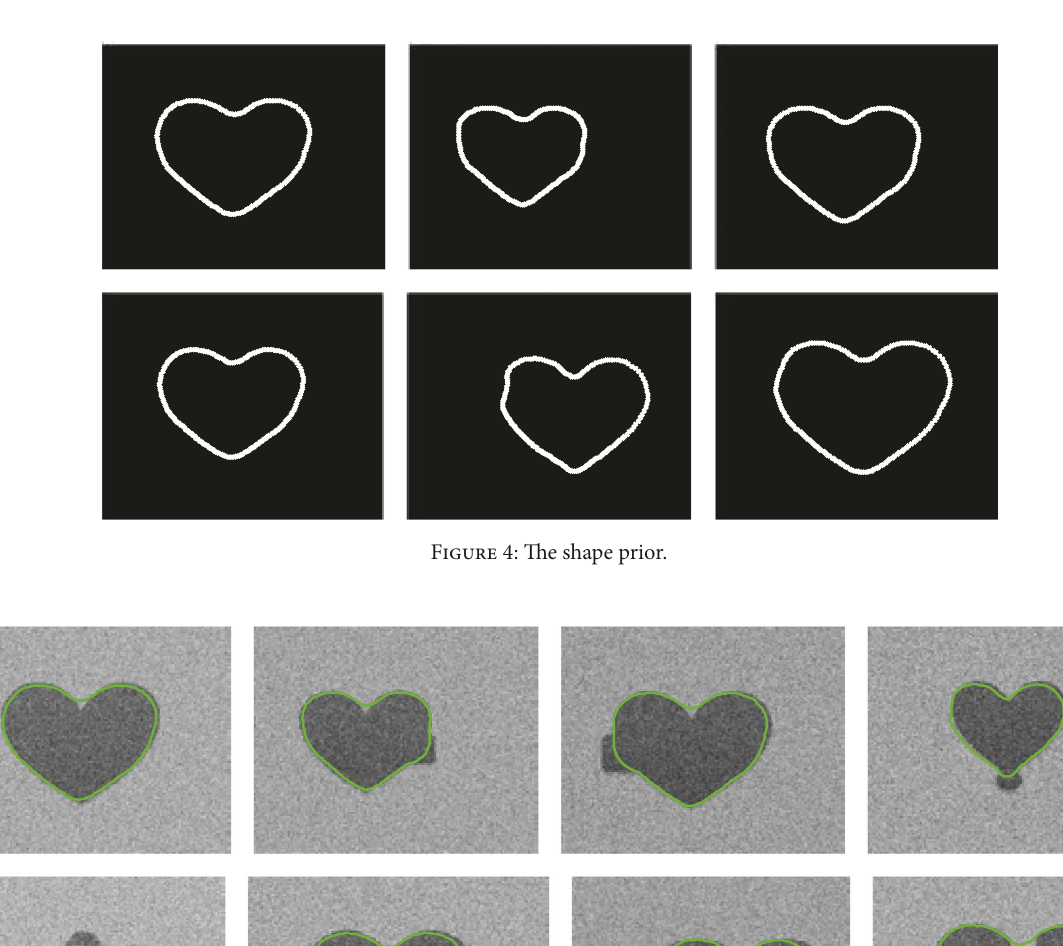
Figure 3: The results with the parametric C-V model.